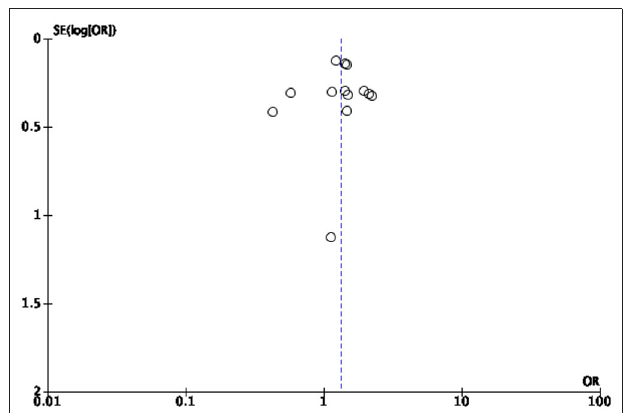
FIGURE 5 | Publication bias for